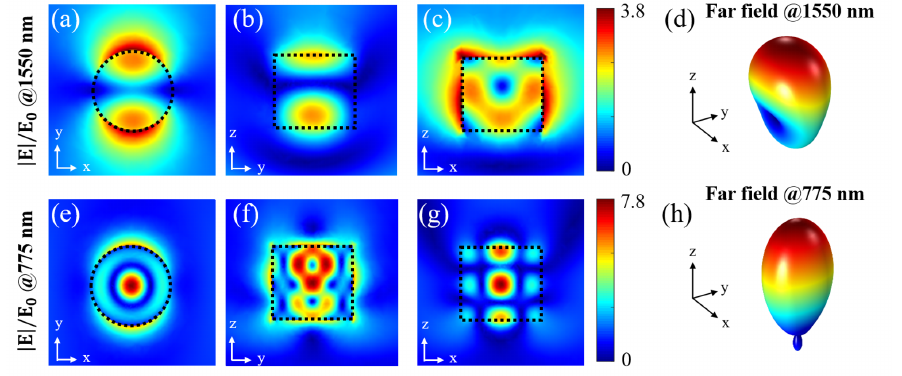
Figure 2. Near-field distributions of the electric field magnitude for the nanodisc radius being r 0 = 215 nm at the pump wavelength of ( a – c ) λ = 1550 nm and ( e – g ) ń = 775 nm, and the corresponding far-field patterns at the pump wavelength of ( d ) λ = 1550 nm and ( h ) ń = 775 nm,